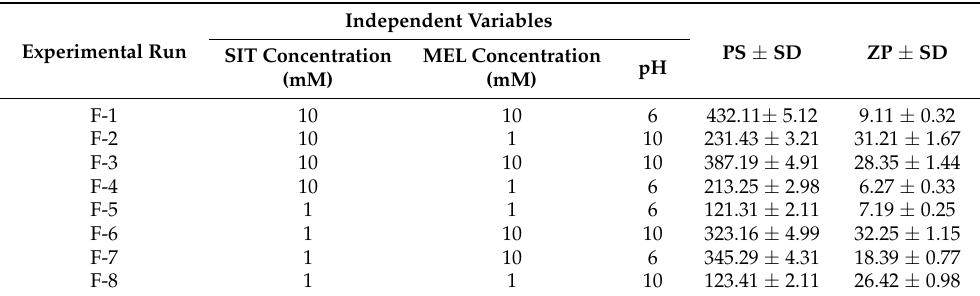
Table 2. Experimental runs and the observed of responses of SIT-MEL nano-sized systems prepared in accordance with 2 3 factorial